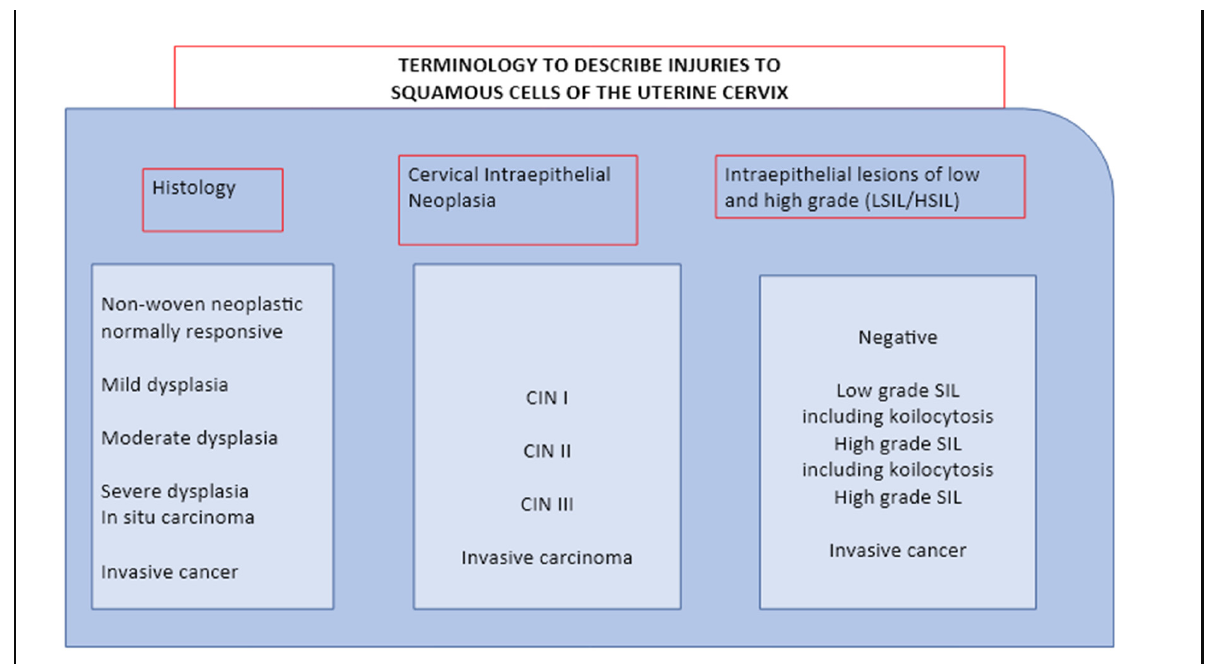
Figure 2. Epidemiology of HPV infection and cervical cancer.